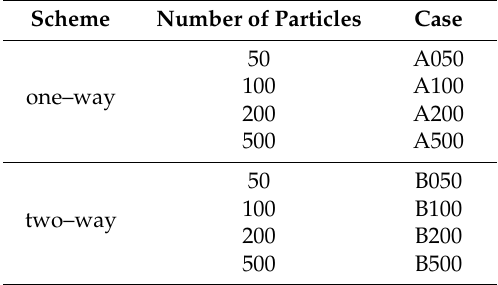
Table 2. Test cases in the multiple particle–wall collision simulation.